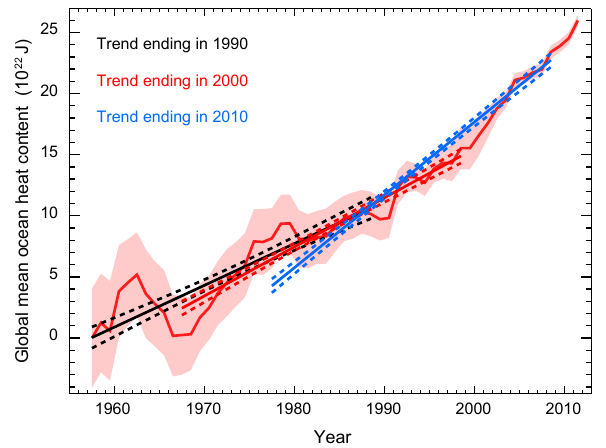
Figure 9. As in Fig. 9, except the diagnostic length is held fixed. Linear trend estimates are for the 1955–1990 (black), 1965–2000 (red), and 1975–2010